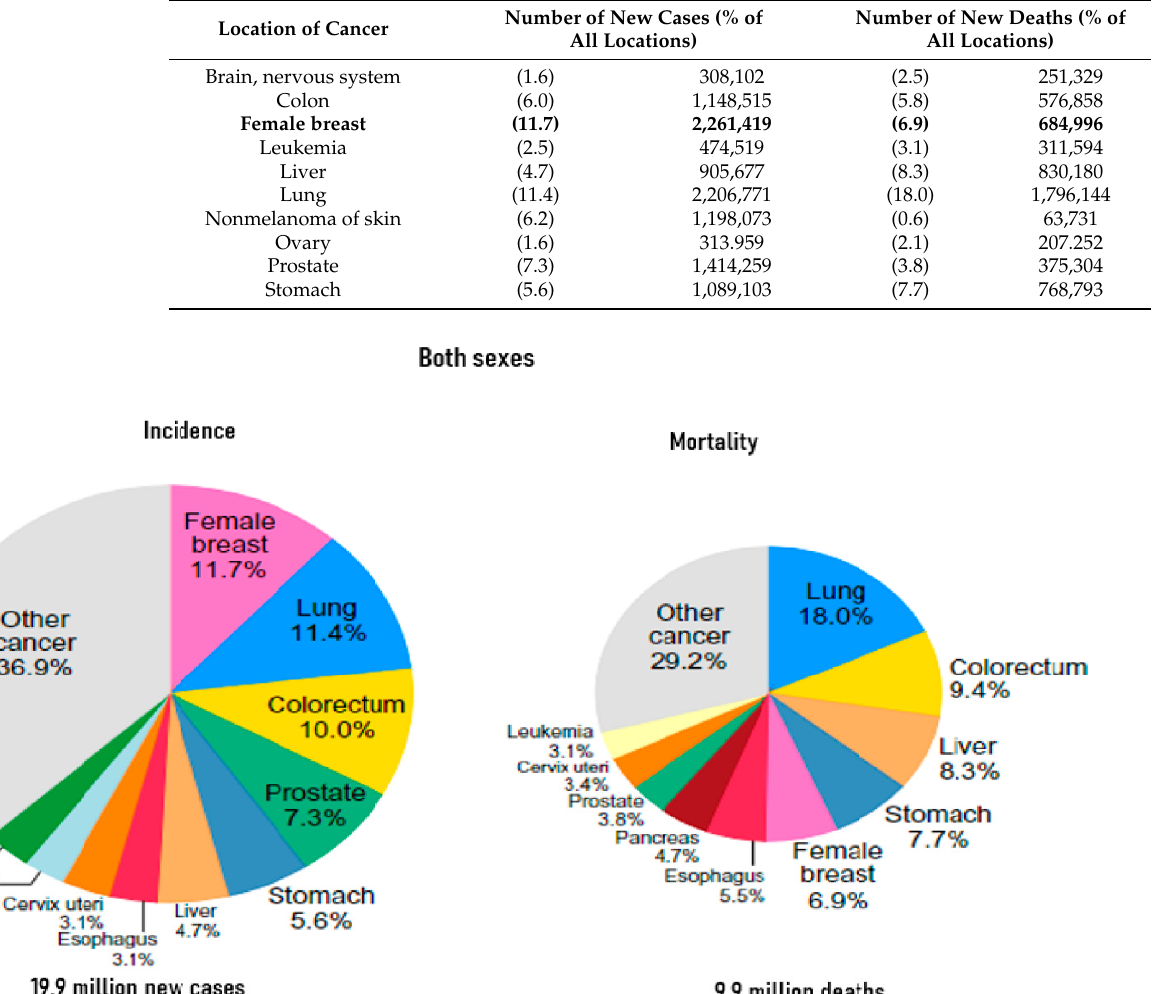
Table 1. New cases and deaths for 10 cancer types in 2020.